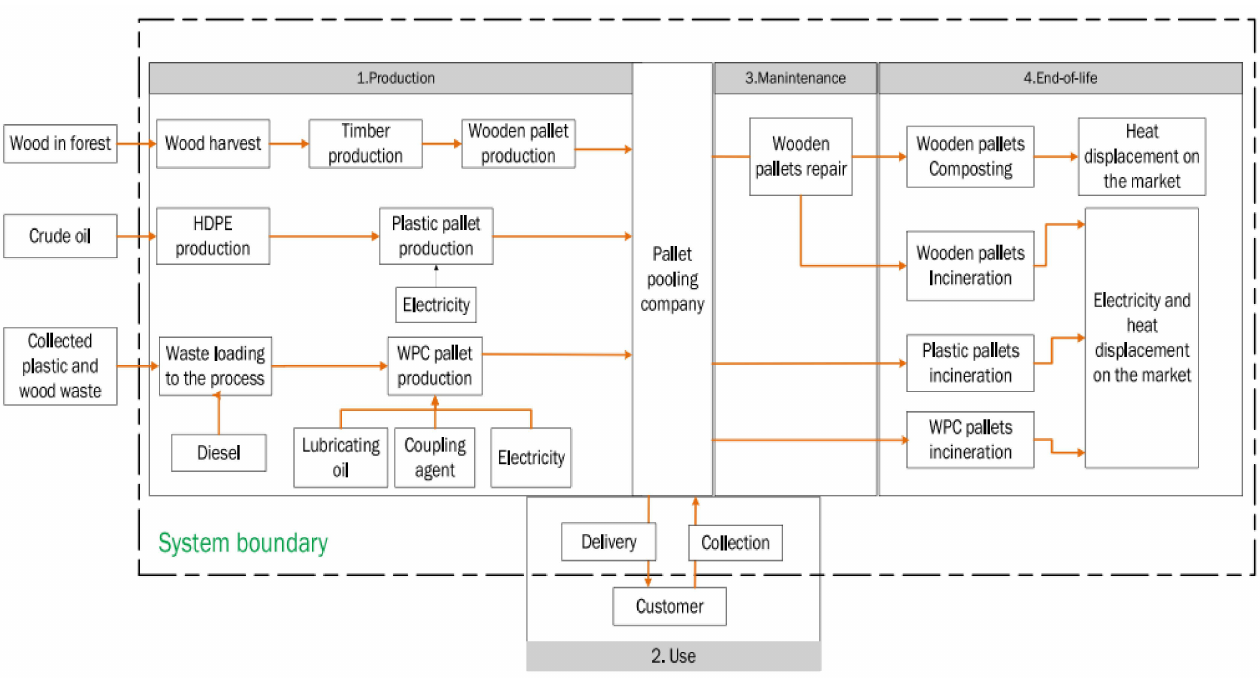
Figure 6. Scope of ALCA studies, Reproduced from [271], Springer,